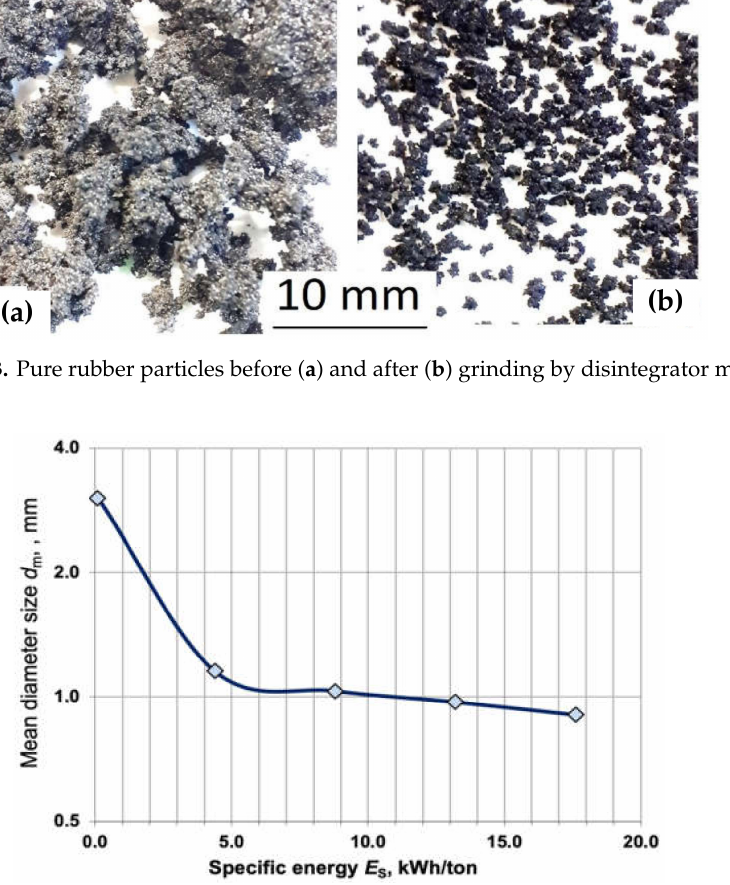
Figure 14. Dependence of the mean diameter size ( d m ) of treated pure rubber on the specific energy of disintegrator milling ( E S ).